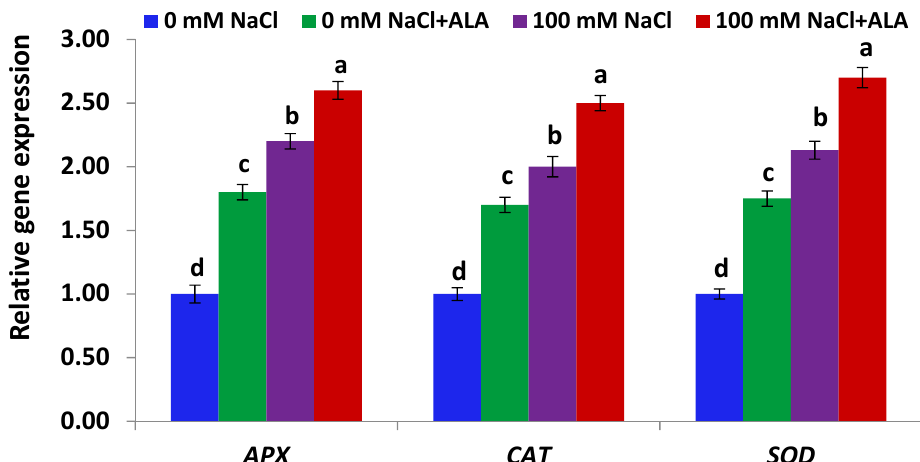
Figure 5. Expression level of antioxidant genes in Slaski 2 cultivar leaves under salt and/or ALA (7 ppm) effects. Values represent means ± SE ( n = 4). Different letters show significant difference among treatments ( p ≤ 0.05).